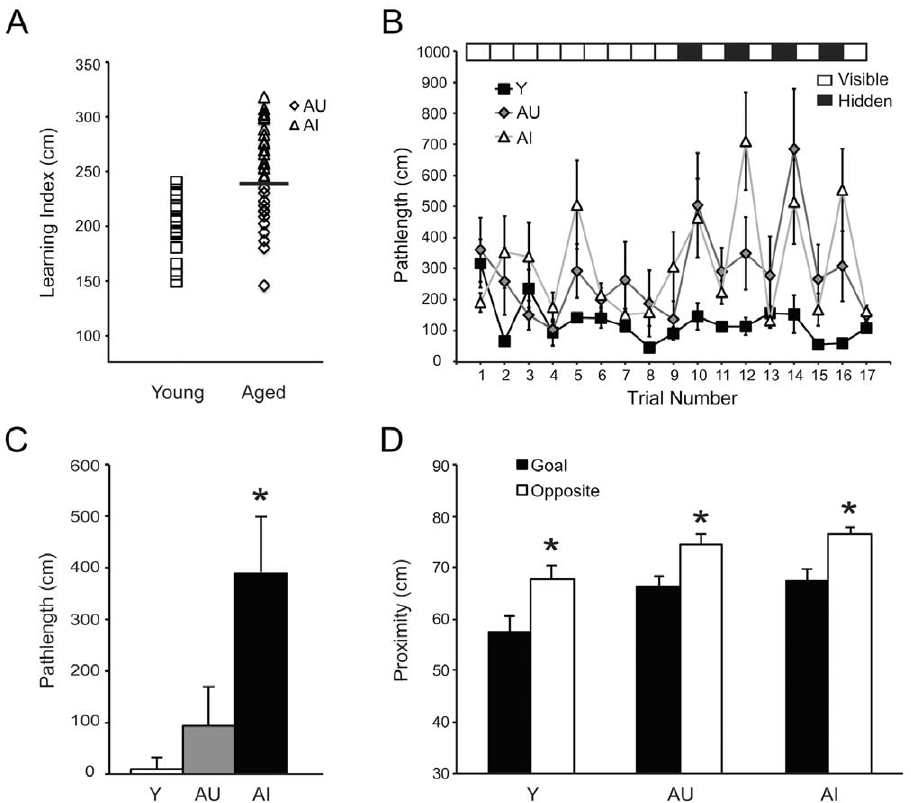
Figure 1. A subset of aged Long-Evans rats displays impaired spatial memory. (A) Learning index scores (a weighted measure of proximity to the platform location across interpolated probe trials) for individual young and aged rats in a standardized spatial version of the Morris water maze. Aged rats (24 mos) that scored within the range of young (Y; 6 mos) were classified as aged unimpaired (AU) and the remainder were classified as aged impaired (AI). (B) Redundant place/cue (RPC) task schematic (top), and escape performance during training, measured as pathlength, in Y, AU, and AI subjects. (C) AI animals displayed impaired spatial learning in the RPC task relative to Y and AU animals, measured as the difference in average pathlength between the last four hidden and visible trials. (D) All groups showed significant spatial bias, measured as proximity to the goal location, during a probe trial provided two hours after the onset of RPC training. Error bars=S.E.M; asterisks indicate p-values , 0.05.